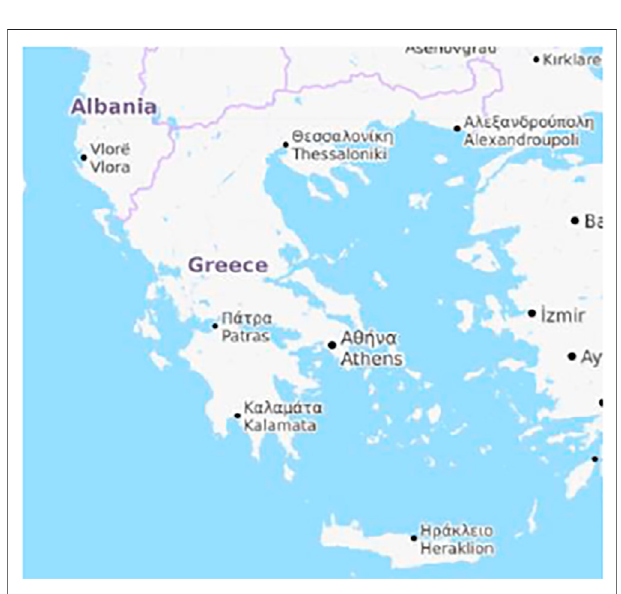
FIGURE 4 | Map of study area. Source: